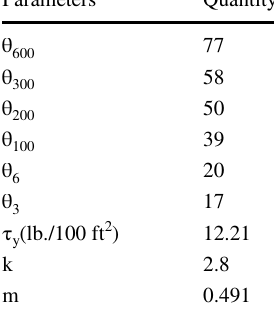
Table 2 Test mud rheology